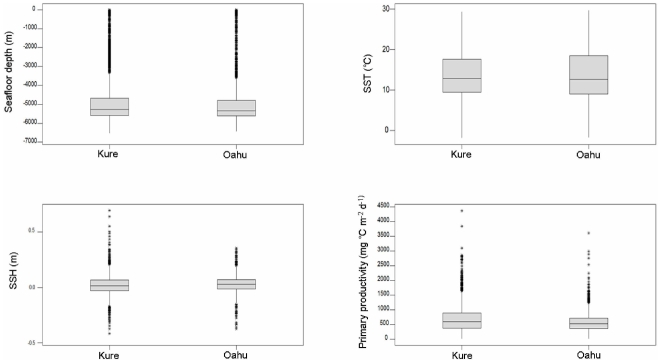
Mean oceanographic parameter values for foraging Laysan albatrosses from Kure and Oahu.Boxplots of bathymetry, SST, SSH, and primary productivity of oceanographic habitats visiting by birds tracked from each colony.